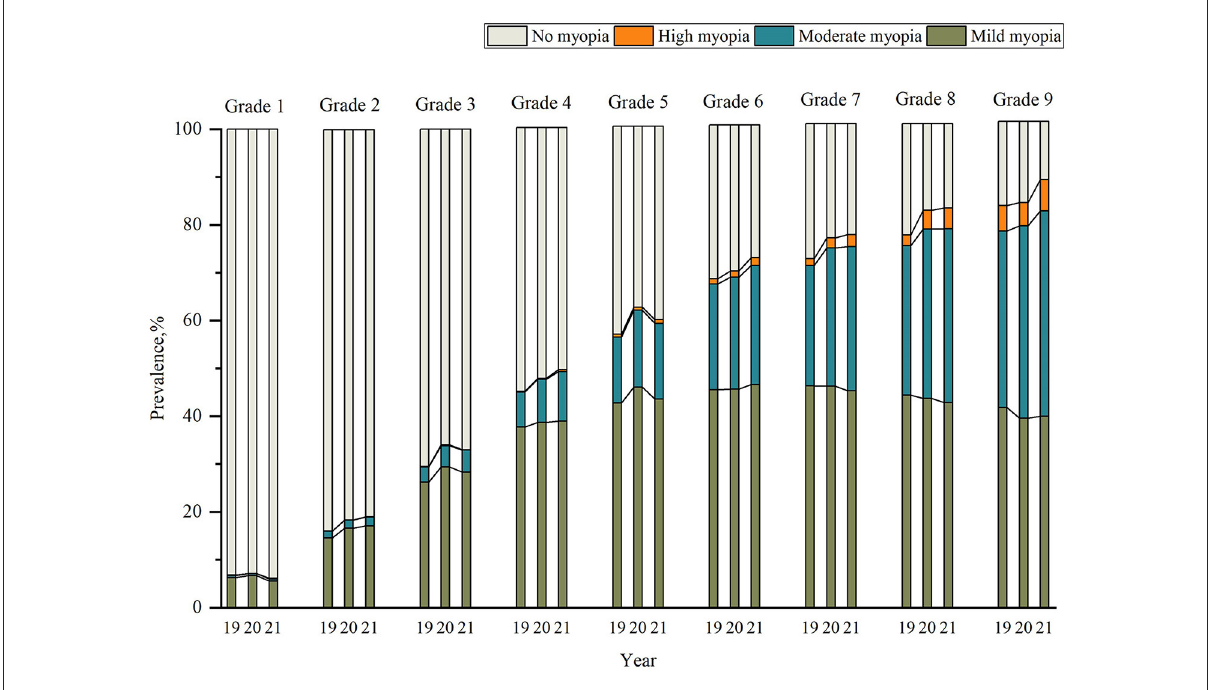
FIGURE2 Changes in the degree of myopia in grades 1–9 over the 3